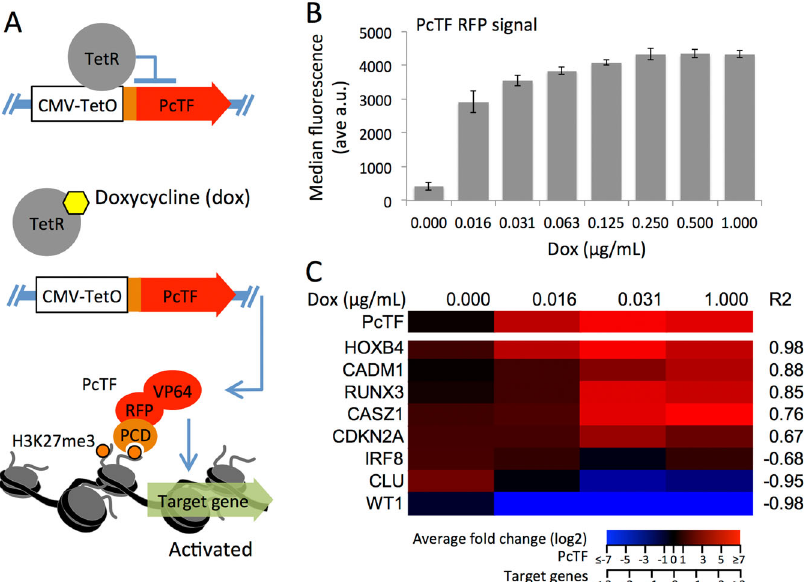
Fig. 3 Polycomb-repressed genes become activated by PcTF in a dose-dependent manner. a The illustration shows doxycycline (dox) induced PcTF expression in U2OS-PcTF cells, leading to accumulation of PcTF at H3K27me3-positive promoters and gene activation. 11 b Flow cytometry analysis of dox-treated cells. Grey bars show average RFP signal ( n = 3, Error = standard deviation). RFP signal histograms and RFP- positive cell frequency are shown in Fig. S4. c qRT-PCR analysis of PcTF and eight genes that showed PcTF-speci fi c activation in transiently transfected U-2 OS cells. The heat map shows average ( n = 3) log 2 fold change ratios for GAPDH -normalized expression in dox-treated cells compared to one of the untreated replicates. R2 = Pearson correlation coef fi cient of average log 2 fold change values for target genes vs.